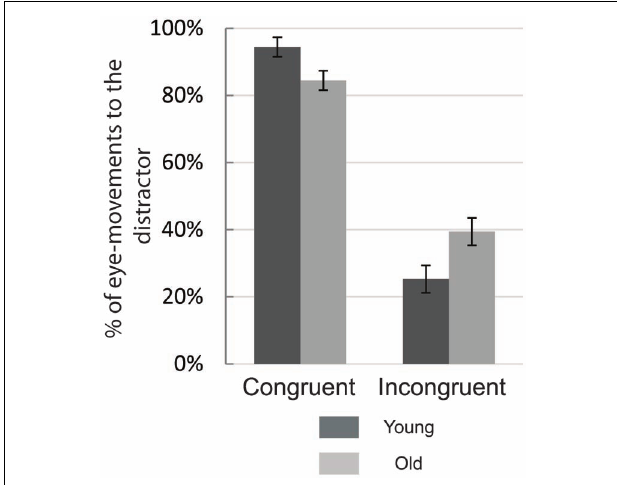
FIGURE 4 | Conditional capture functions (CCFs) for congruent (thin lines) and incongruent (thick lines) trials displaying the percentage of eye-movements toward the distractor ( y -axis) plotted against mean saccade reaction time (SRT; x -axis) for five speed quantiles. Old subjects are depicted with gray lines, while black lines are used for the young group. Error bars represent the